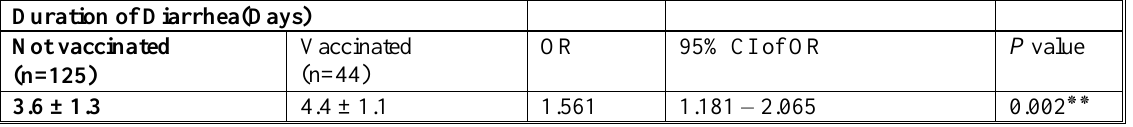
Table 8a. Duration of diarrhea of study population Duration of Diarrhea(Days)